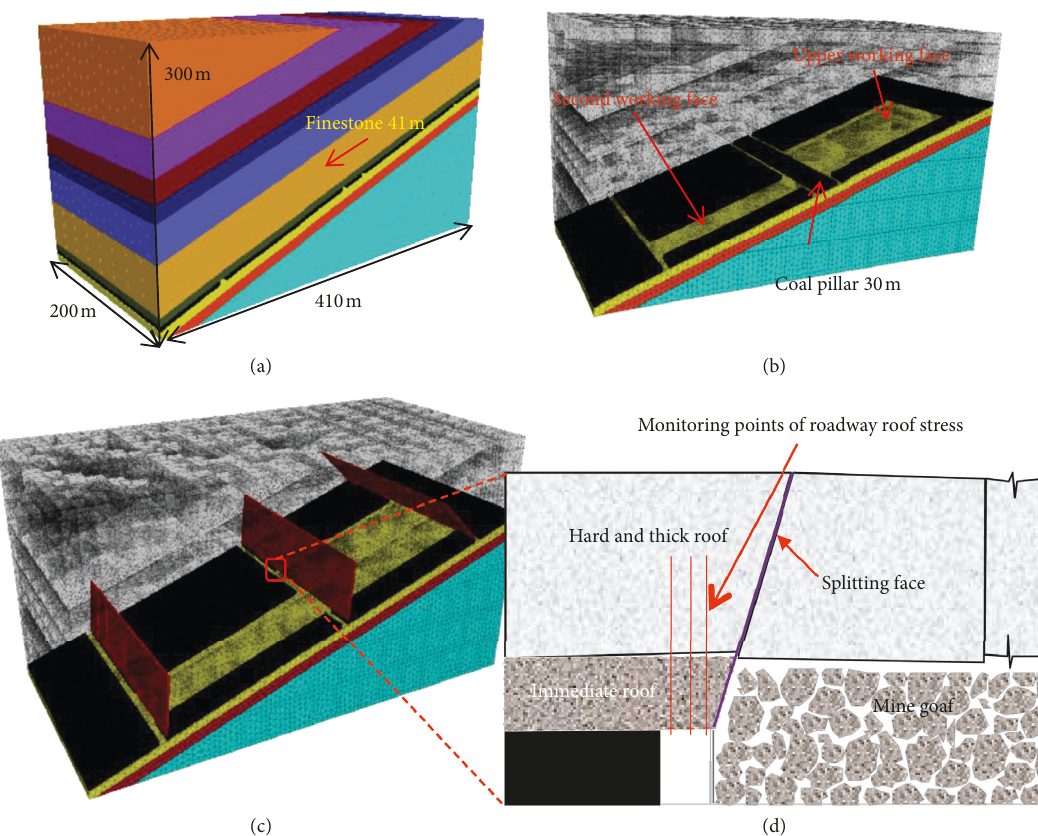
Figure 3: Numerical model, model dimensions, and monitoring points. (a) Numerical simulation model. (b) Conventional mining model. (c) Precut overhanging hard roof model. (d) Monitoring points for roadway roof.